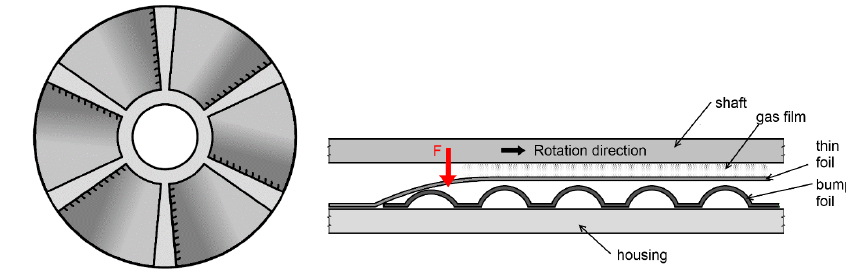
Figure 1: Design of the thrust foil bearing.